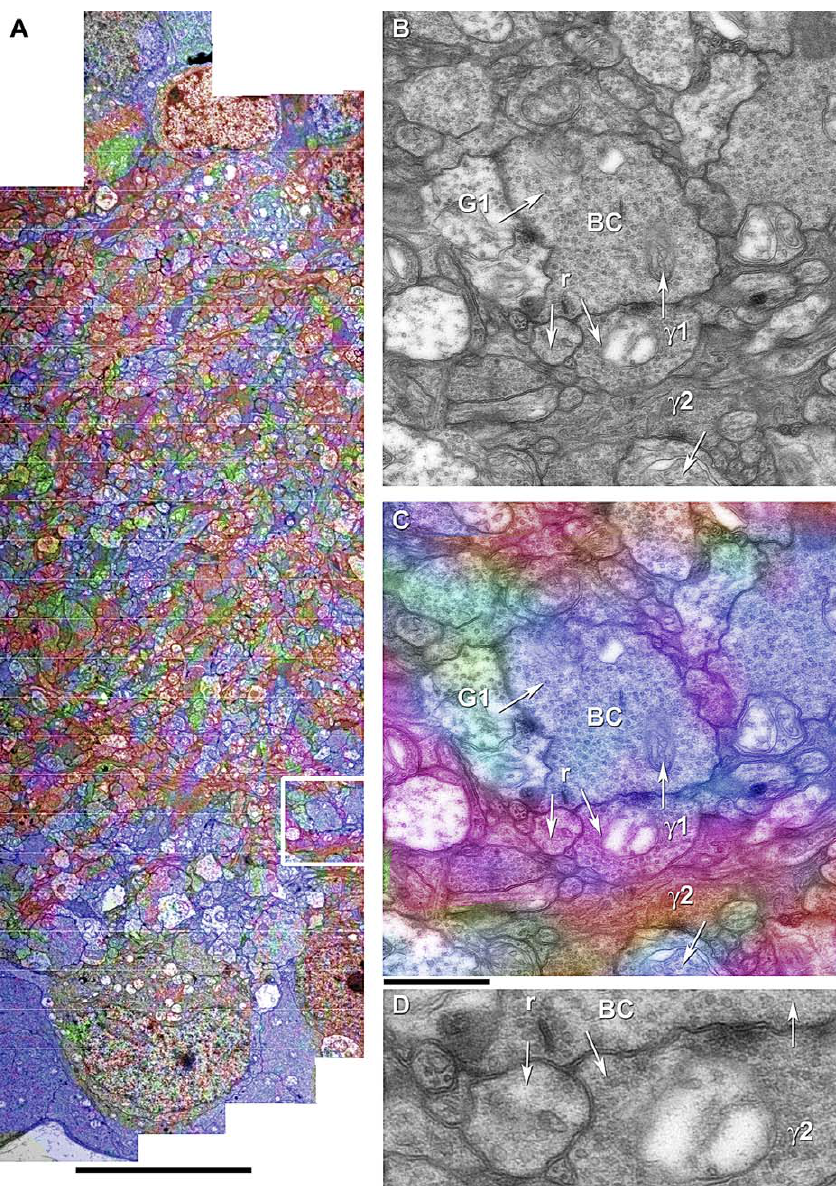
(A) A 20- l m wide strip from a 750- l m wide mouse retinal dataset of the inner plexiform layer extending from the AC layer (top) to the GC layer (bottom). The color map is a c G s :: rgb mapping visualized as a transparency overlay onto the TEM data. Scale 10 l m. (B) The synaptic terminal of an ON cone BC (as identified by its signature and the region of the inner plexiform layer from which it was sampled, outlined in [A]). Four synapses are marked by arrows. The shaft of each arrow originates in the presynaptic process and the arrowhead lie in the